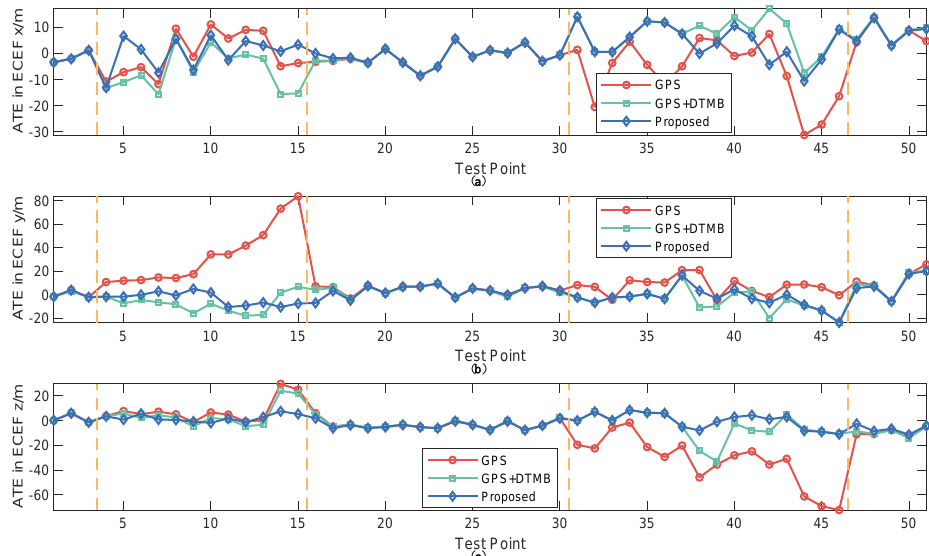
Figure 14. ATE of the three methods at each test point at Site 1: ( a ) ATE in x axis direction of the ECEF system; ( b ) ATE in y axis direction of the ECEF system; and ( c ) ATE in z axis direction of the ECEF system.